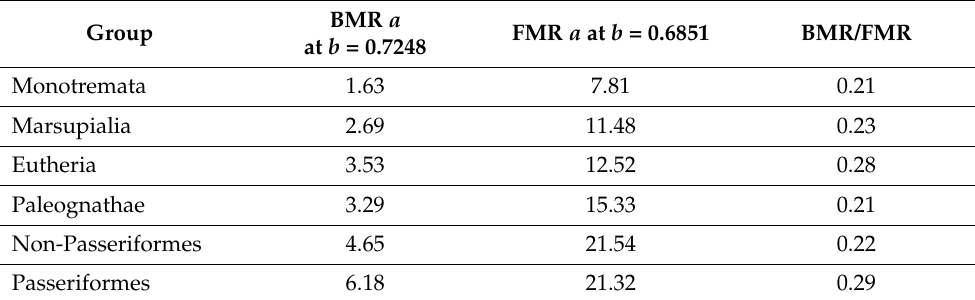
Table 4. Relation between BMR and FMR in major groups of endothermic animals. BMR a FMR a at b = 0.6851 Group at b = 0.7248 Monotremata Marsupialia Eutheria